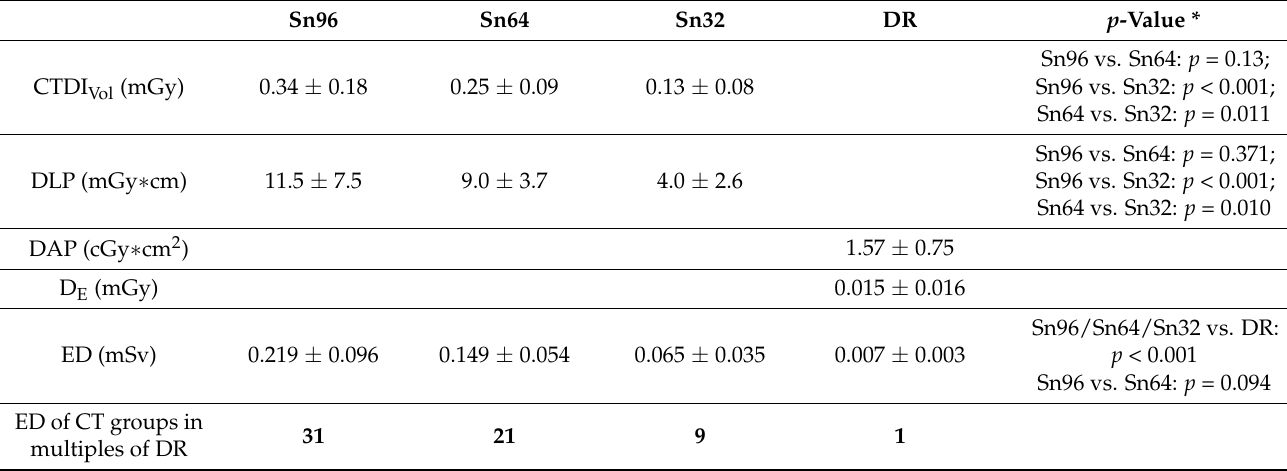
Figure 3. Comparative detectability of lung lesions in patients with cystic fibrosis in low-dose DSCT (ADMIRE 4) and DR. Sn96: 13-year-old girl, Sn64: 10-year-old boy, Sn32: 17-year-old boy and DR: 17-year-old boy. Bronchiectasis, bronchial wall thickening and mucoid impactions are marked with an asterisk. Detectability of lung lesions is acceptable in all DSCT groups and limited in DR. Table 4. Radiation dose